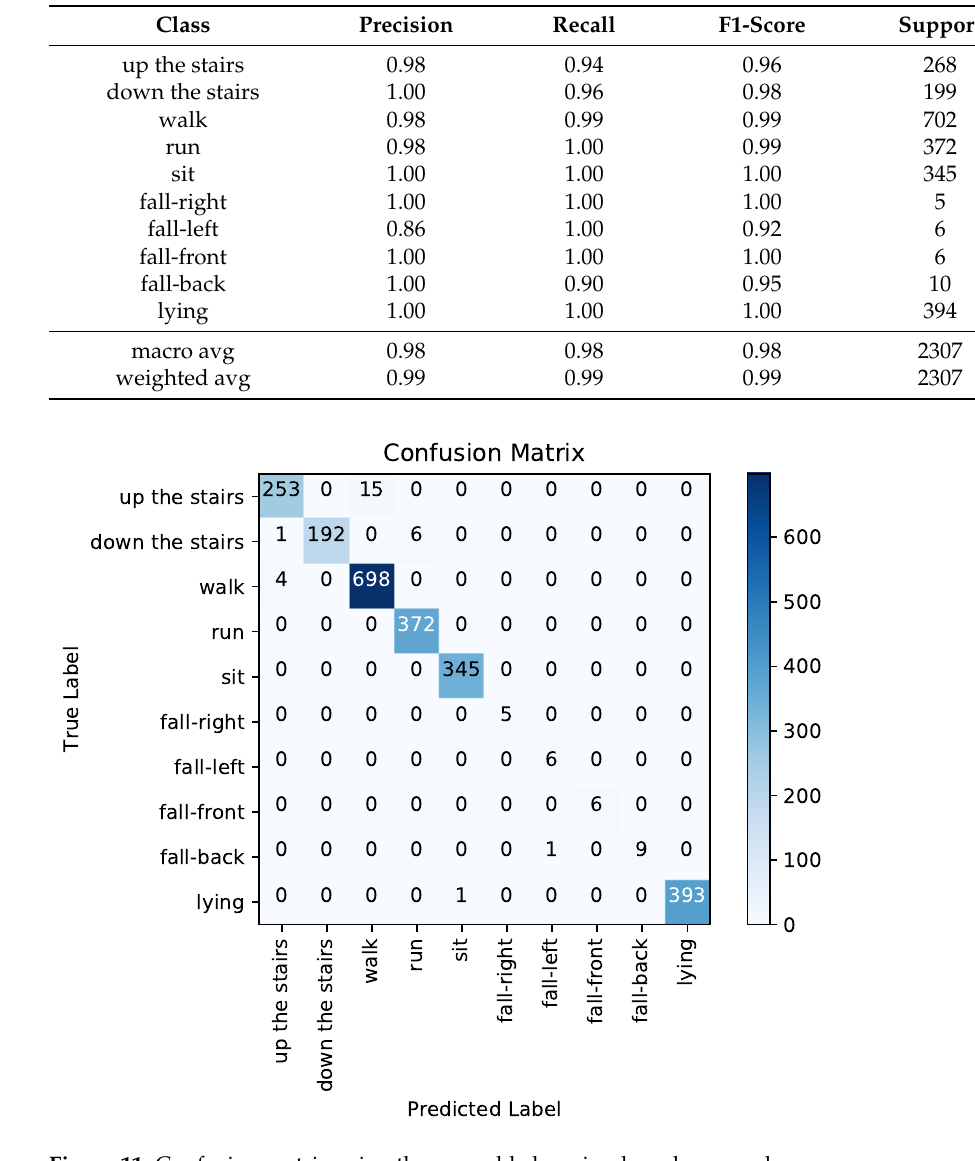
Figure 11. Confusion matrix using the ensemble learning-based